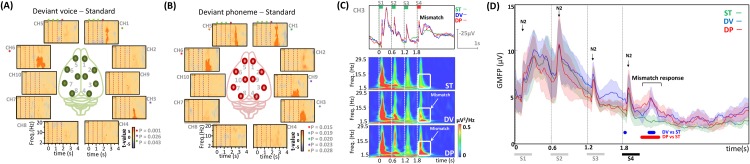
Auditory mismatch response.(A-B) Comparison of the time-frequency decomposition for each deviant vs. standard trial. Pale red colors represent positive clusters (i.e. deviants had larger t-values than standard conditions) and negative clusters are marked with light blue colors (i.e. deviants had smaller t-values than standard conditions). Significant positive clusters are marked with pale red color. Each cortical area is dominated by activity in the theta to beta range over a certain period of time. The probability level under which the specific cluster is significant is shown in the right bottom corner. Red dotted vertical line indicates the onset of each of the four syllables. (C) Time-course of the grand average ECoG signal of three conditions (ST, DV, DP) showing habituation in terms of amplitude. The mismatch response is observed in time-domain and ECoG time-frequency maps of three different conditions. (D) Time-courses of the grand average and standard deviation of Global mean field power (GMFP) in deviant phoneme (DP), deviant voice (DV), and standard (ST) trials. The peaks corresponding to N2 are indicated. The strongest mismatch response was observed over the period 300 to 800 ms, corresponding to the N3-evoked potential component (horizontal lines are plotted when significant differences are observed; DV vs. ST blue color, DP vs. ST red color). The gray rectangles indicate the duration of the syllable.